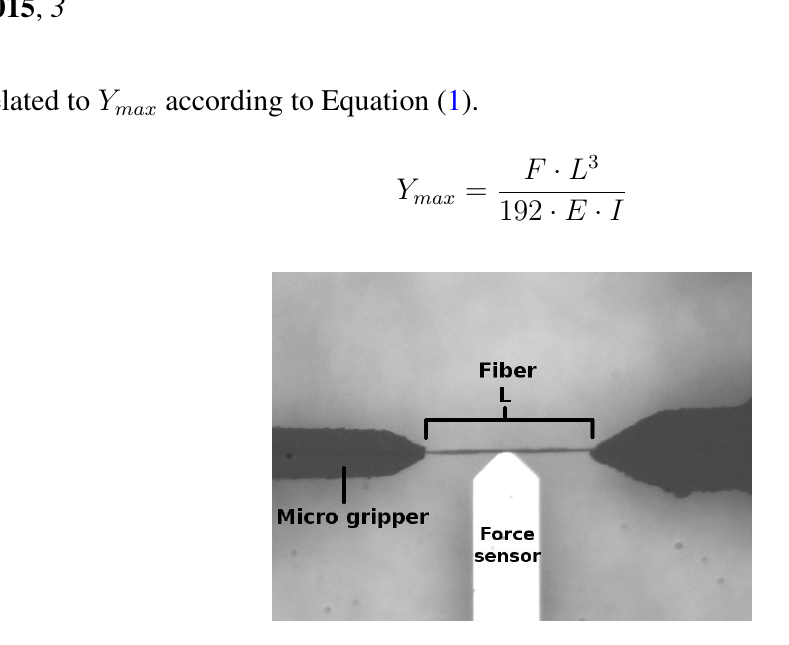
Figure 1. An image of the setup in the microrobotic platform for compliance